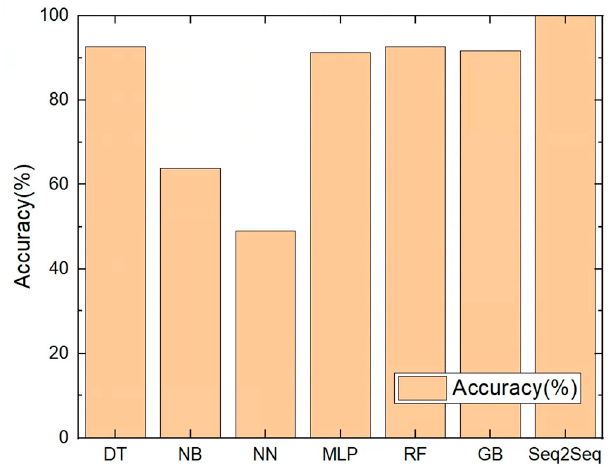
Figure 13. Accuracy comparison with other ML methods.